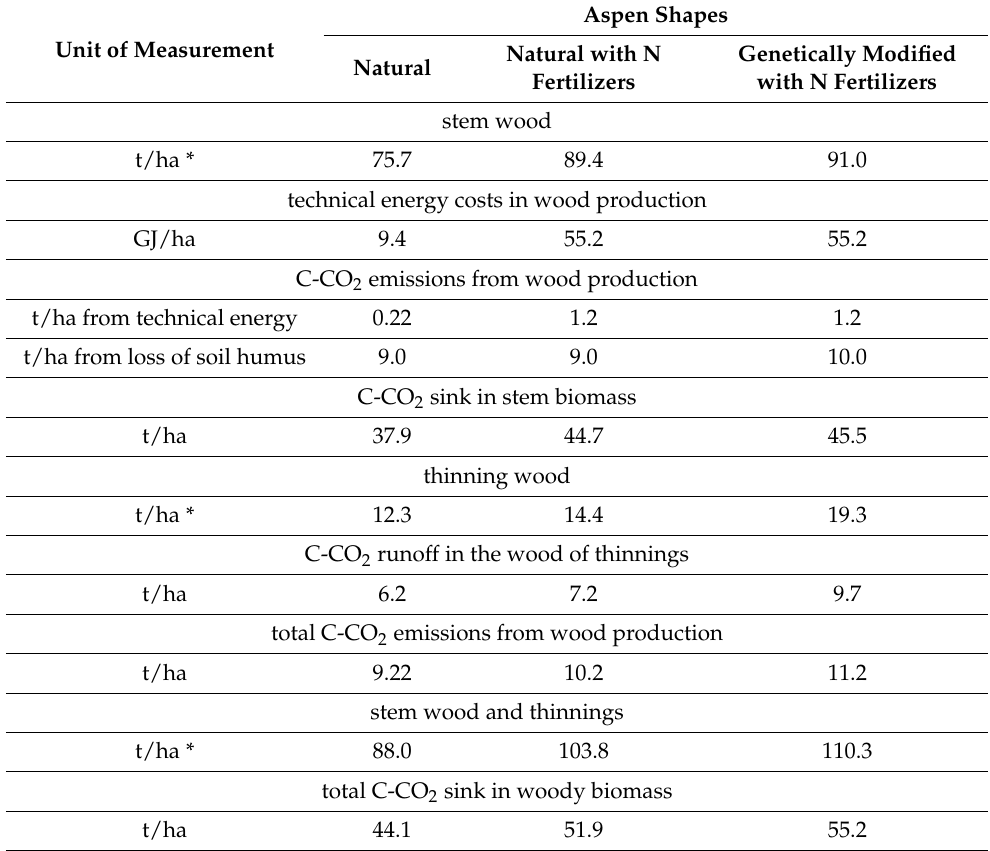
Table 1. Balance in plantations of natural and genetically modified forms of aspen Populus tremula L. (second rotation of plantation). Aspen Shapes Unit of Measurement Natural with N Natural